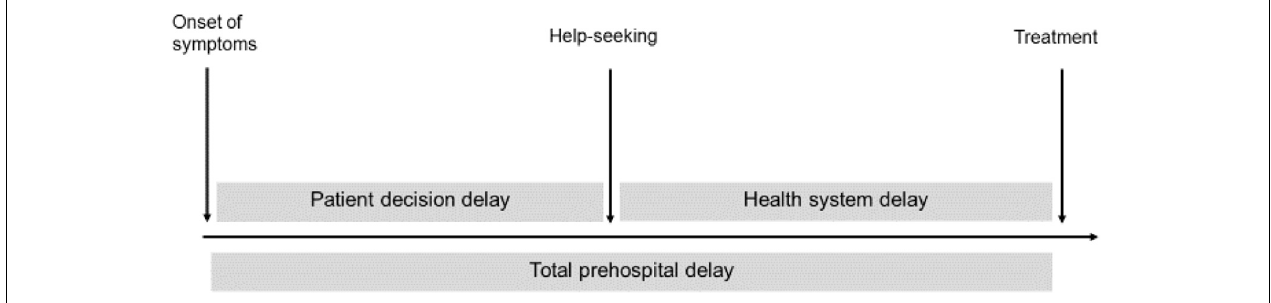
FIGURE 1 | Phases of prehospital